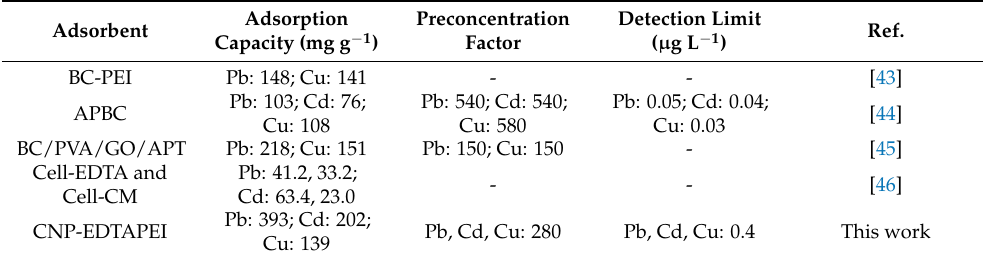
Table 6. Adsorption of metal ions by different cellulose-based